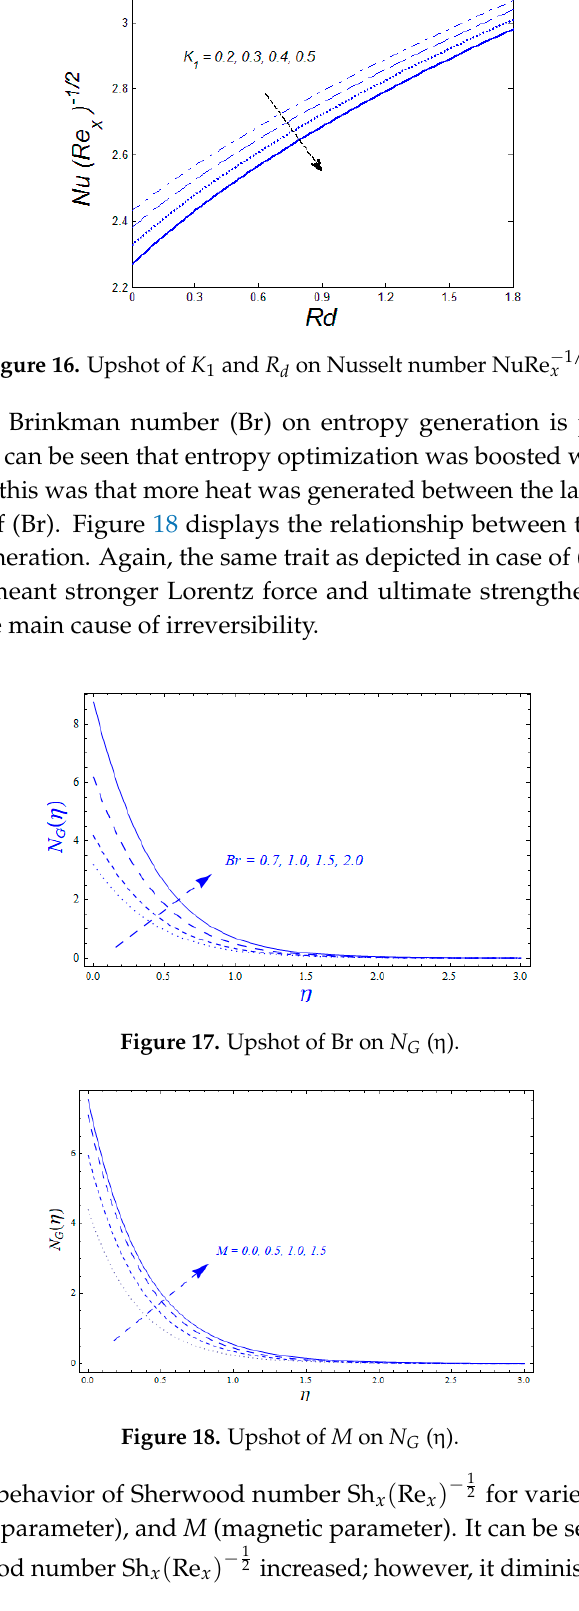
1 and R d on Nusselt number